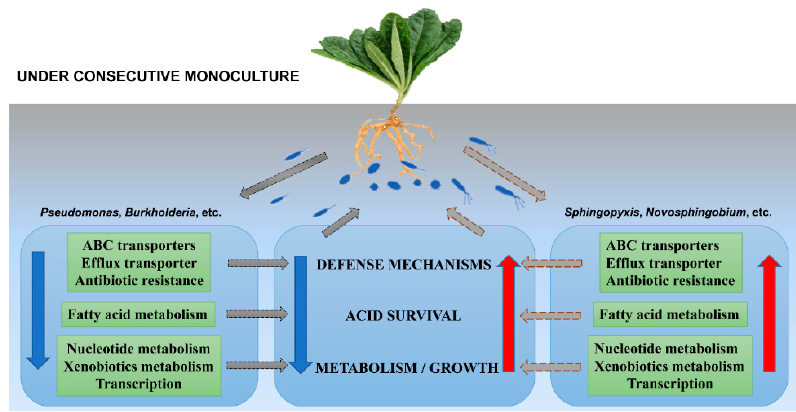
Figure 6. Model illustrating the proposed microbial phylogenetic and functional responses to R. glutinosa consecutive monoculture. Dashed grey arrows represent the process flow sequence. Blue solid arrows represent the down-regulation of functional potentials in several microbes under monoculture and red solid arrows represent the up-regulation of functional potentials in several microbes under monoculture.